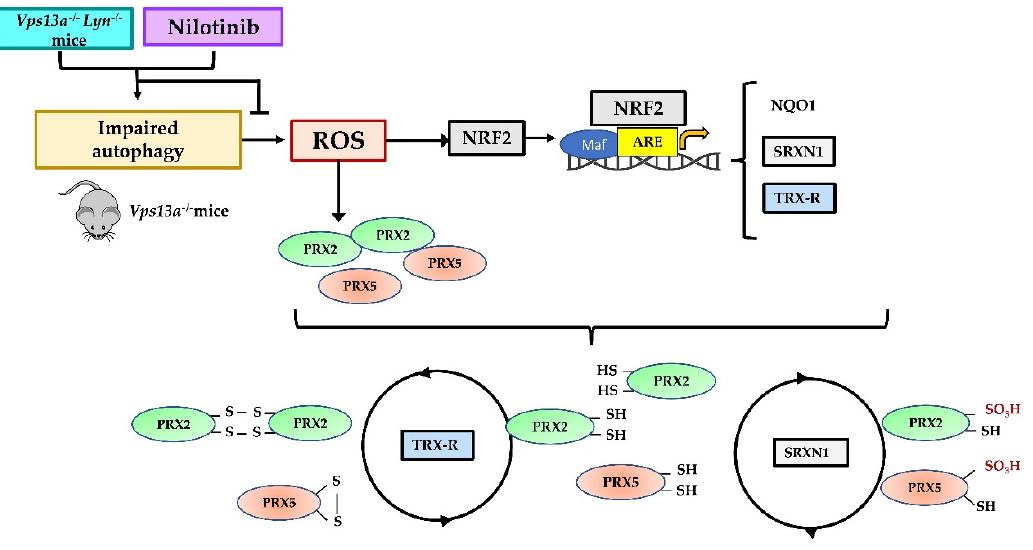
Figure 6. Schematic diagram. Vps13a − / − mice are characterized by impaired autophagy and neuroin- flammation, with increased production of reactive oxygen species (ROS). Therapeutic activation of redox-related transcriptional factor NRF2 binds to antioxidant-responsive elements (ARE) of specific genes, promoting transcription of antioxidant proteins such as NQO1, SRXN1 and TRXR, in order to counteract producction of ROS and other reactive species. TRXR is required to reduce and reactivate PRX2 and PRX5. In highly oxidized environments, Prxs can be overoxidized (PRX-SO3). SRXN1 can restore overoxidized Prxs to their functional reduced state. These antioxidant proteins together orchestrate preservation of a beneficial equilibrium between antioxidants and oxidants. In double knockout Vps13a − / − ; Lyn − / − mice and in Vps13a − / − animals treated with nilotinib, amelioration of authophagy beneficially affects oxidation, resulting in reduced ROS production.